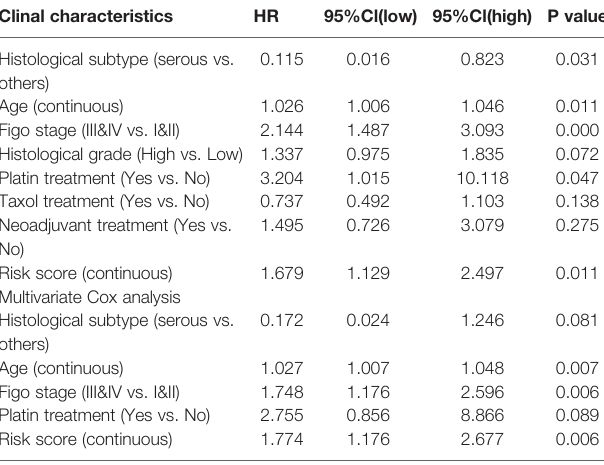
TABLE 4 | Associations with overall survival and clinicalopathologic characteristics in GEO patients using COX regression. Clinal characteristics